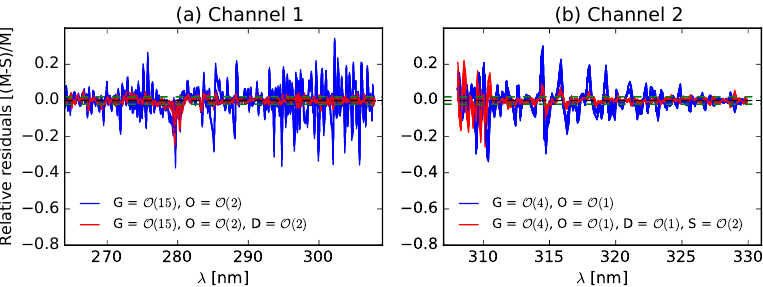
Figure 9. Relative residuals of daily SCIAMACHY L1 v8 solar spectra for Channel 1 (a) and Channel 2 (b) , found by optimising the slit function parameters O , G , D and S . The residual is defined as (M − S)/M , where M is the SCIAMACHY measured irradiance and S is the solar reference spectrum. For visibility, the residuals for only ∼ 300 spectra are shown, which are representative of the entire mission from August 2002 to April 2012. The dashed lines mark the values of 0 and ±